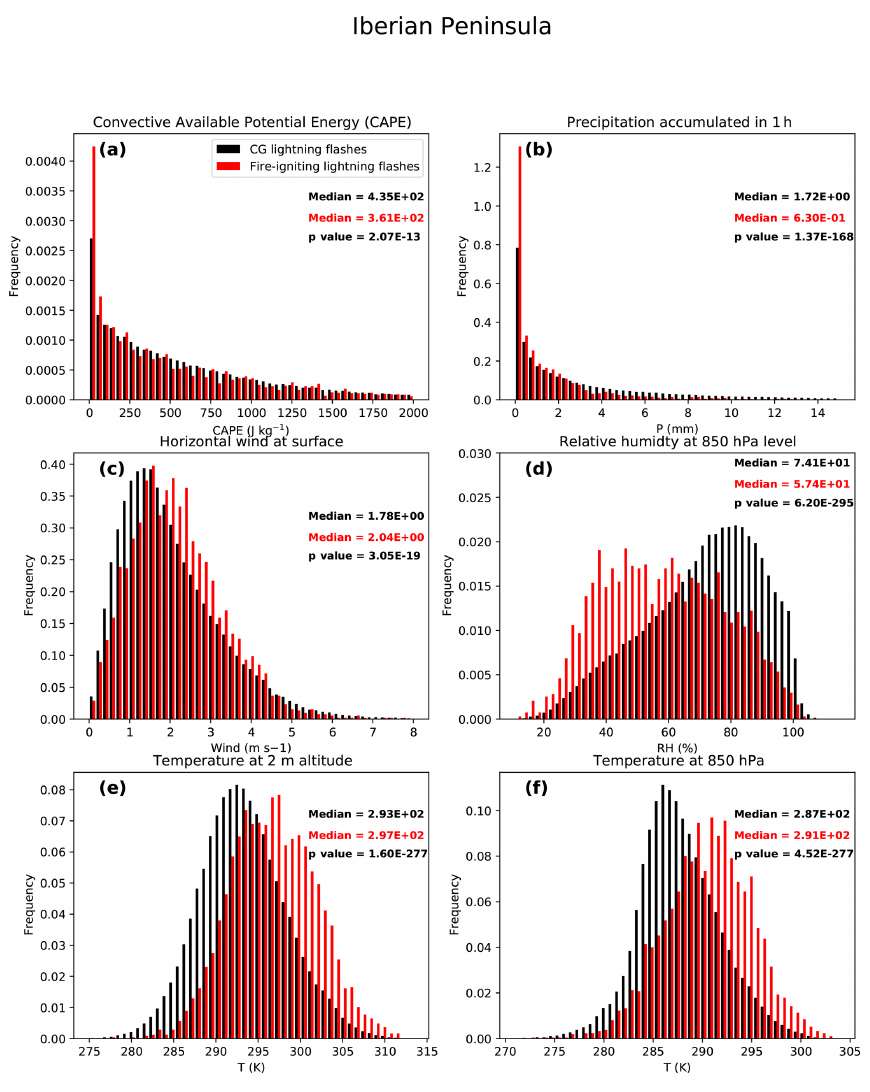
Figure 5. Frequency distribution of the convective available potential energy (CAPE), the hourly accumulated precipitation, the horizontal wind at surface, the relative humidity at 850hPa level and the air temperature at 2m and at 850hPa level for the CG lightning, and the fire-igniting lightning climatologies in the Iberian Peninsula between 2009 and